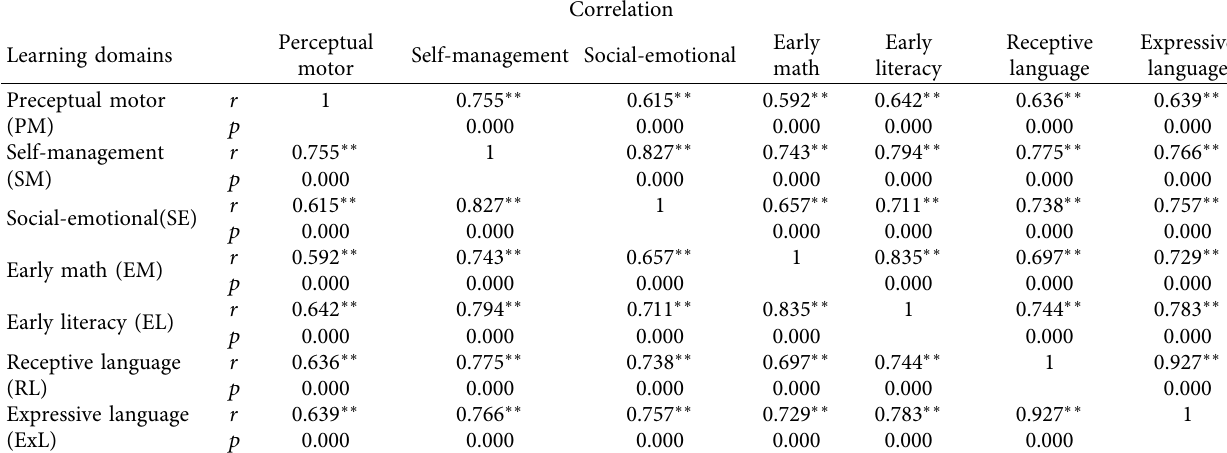
Table 10: Pearson correlation matrix regarding learning